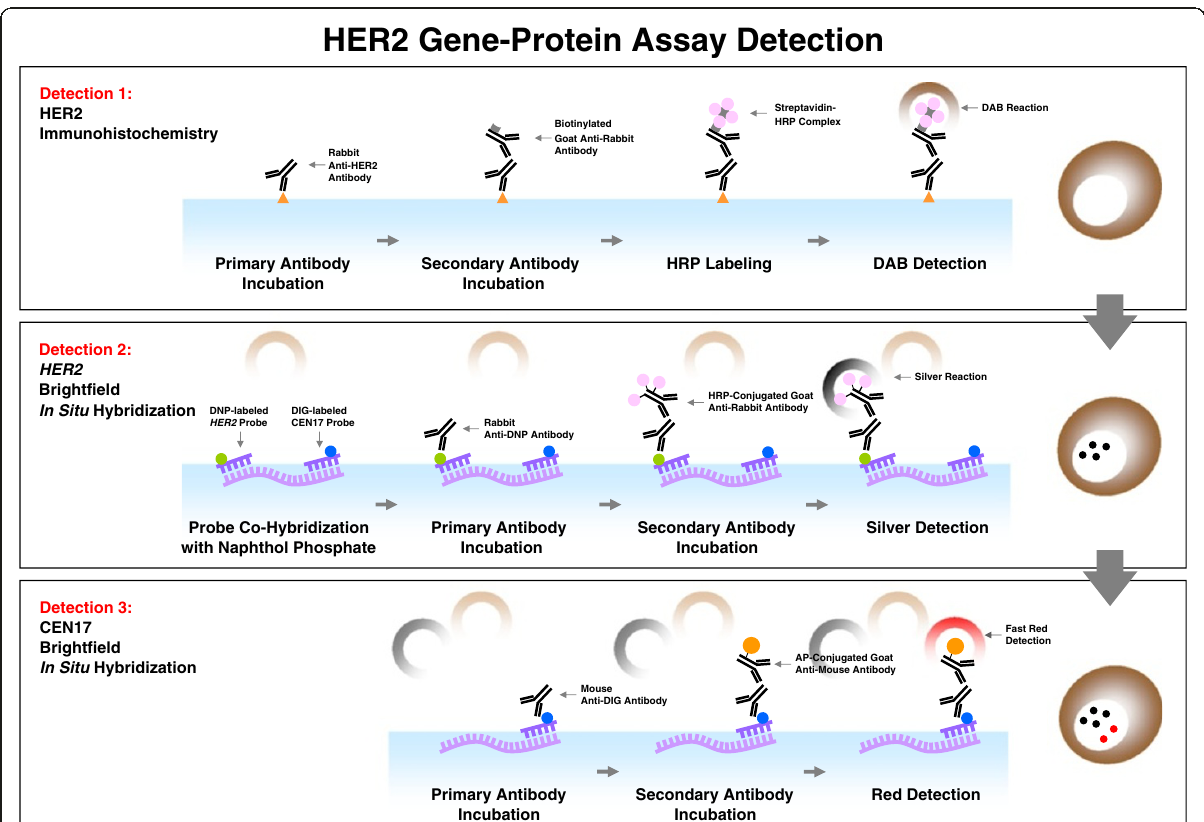
Figure 1 Scheme for simultaneous visualization of human epidermal growth factor receptor 2 (HER2) protein, the HER2 gene, and the chromosome 17 centromere (CEN17) using a novel HER2 gene-protein assay. First, HER2 protein is localized through immunohistochemical staining (IHC) with a rabbit monoclonal anti-HER2 antibody and a conventional 3,3 ′ -diaminobenzidine (DAB)-based detection method. Then, the HER2 gene and CEN17 are localized by brightfield in situ hybridization (BISH) with a cocktail of 2,4-dinitrophenyl (DNP)-labeled HER2 probe and digoxigenin (DIG)-labeled CEN17 probe. The HER2 gene and CEN17 signals are visualized with silver (a silver acetate, hydroquinone, and hydrogen peroxide reaction) and fast red (a fast red and naphthol phosphate reaction),